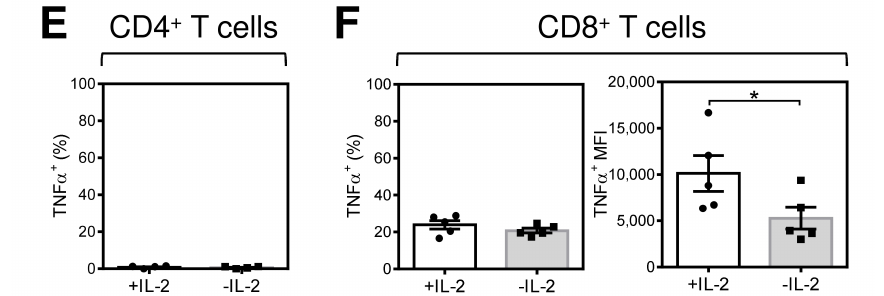
Figure 1. Acute starvation of IL-2 diminishes the robustness of the immediate response of expanded CD8 + T cells following stimulation with antigen. The 14-day-expanded lymphocytes were reconstituted and cultured for 18–24 h in LM medium supplemented with IL-2 (80 IU / mL). The cells were pelleted, washed two times with LM medium, and resuspended in fresh LM medium with or without IL-2 (80 IU / mL) and cultured for 18–24 h. The cells were washed, resuspended in fresh medium with or without IL-2 (80 IU / mL), and stimulated by coculturing with PC-3 cells at a ratio of 4:1 (lymphocytes:PC-3 cells). The released IFN γ and TNF α levels into the supernatant after 20-h stimulation were determined by ELISAs, and TNF α intracellular production after 5-h stimulation by flow cytometry. ( A ) The calculated concentrations (pg / mL) of IFN γ and TNF released into the supernatants by 1 × 10 6 / mL cell suspensions. ( B ) The gating strategy used to analyze the flow cytometry data. ( C ) The proportions of the IFN γ + population of CD4 + T cells. ( D ) The proportion of the IFN γ + population and its intensity of staining (MFI) of CD8 + T cells. ( E ) The proportions of the TNF α + population of CD4 + T cells. ( F ) The proportion of the TNF α + population and its intensity of staining (MFI) of CD8 + T cells. In ( A , C – F ), bars represent the mean of values determined in each group, and the significance of di ff erences between the group of cells with ( + ) or without ( − ) IL-2 is indicated (* p < 0.05, n = 5 donors, paired 2-tailed Student’s t